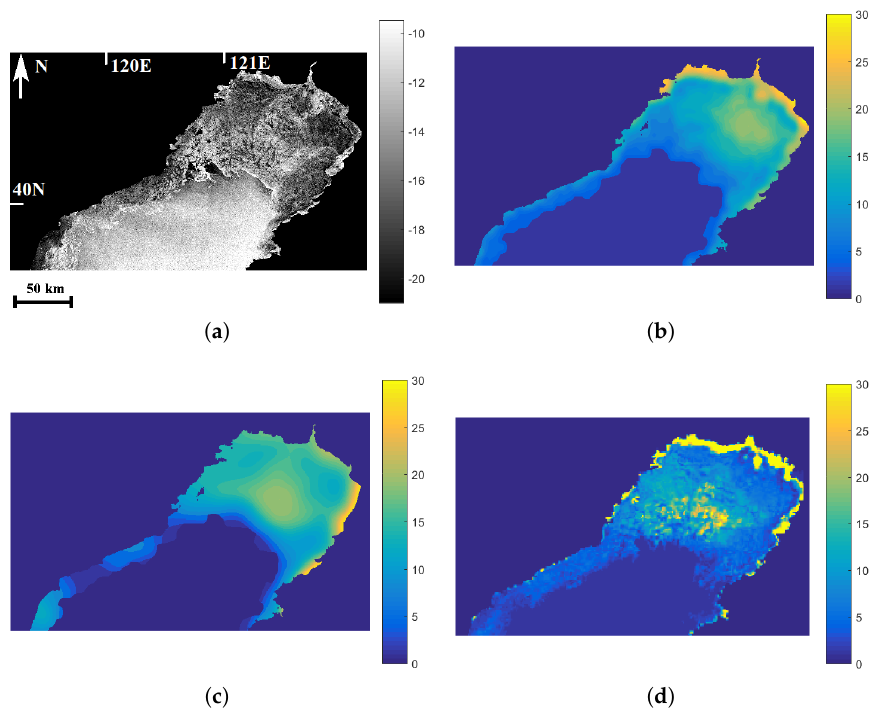
Figure 7. ( a ) RADARSAT-2 HH channel SAR; ( b ) HIGHTSI SIT; ( c ) HIGHTSI/AMSR2 SIT used as a background field for our SIT estimation algorithm; and ( d ) MODIS SIT estimate on 9 January